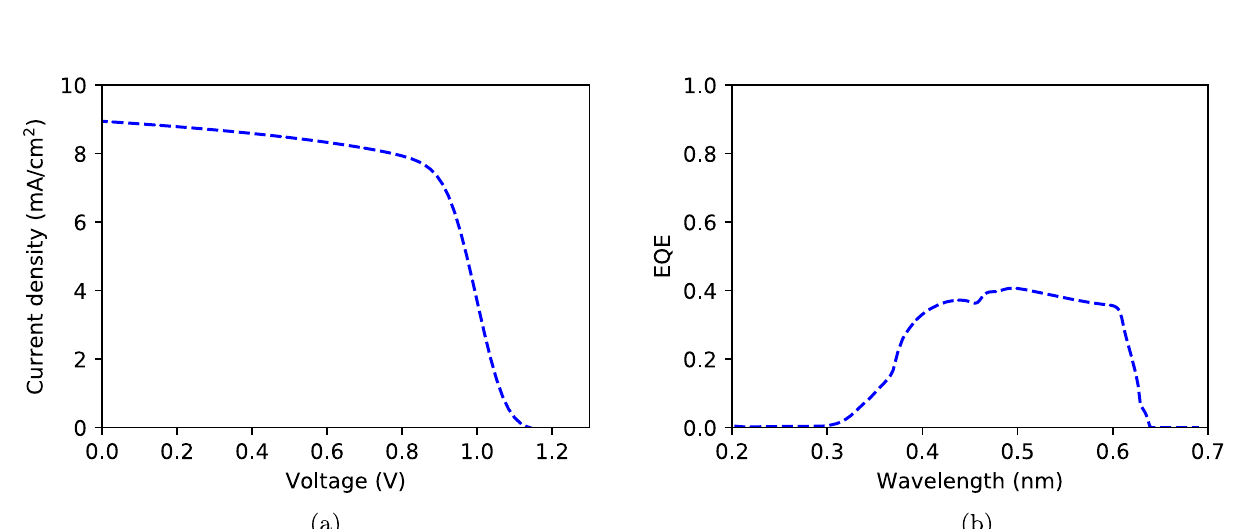
Fig. 2. Characteristics of the AZO/Zn 1 (cid:1) x Ge x O/Cu 2 O solar cell with a germanium composition x = 0.62. (a) Current-Voltage characteristics. (b) External quantum ef fi